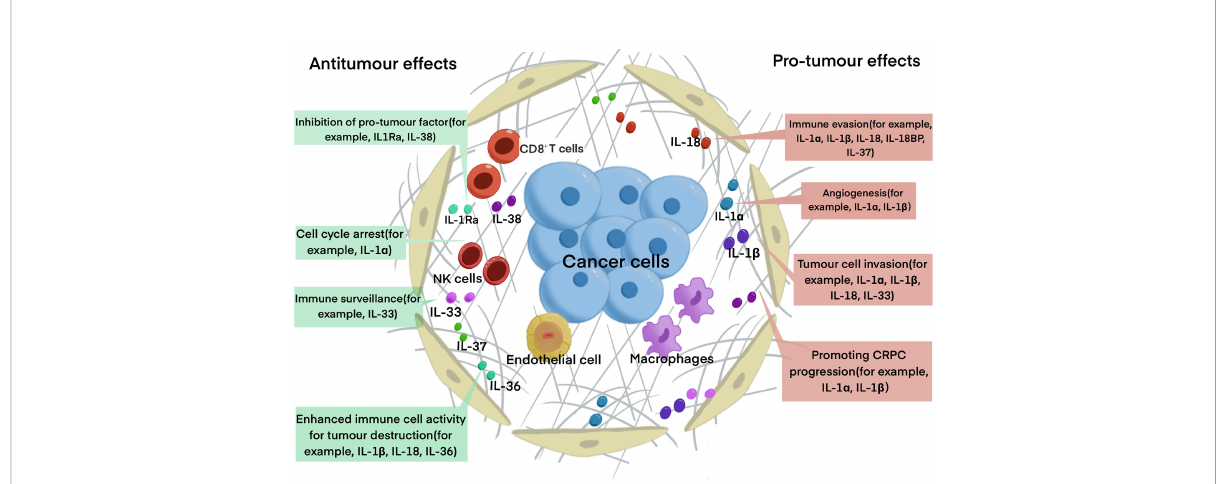
FIGURE 2 The roles of IL-1 family in PCa progression. The diagram summarized the major function of IL-1 family has in PCa progression. Some of the cytokines, for example, IL-1Ra, IL-33 and IL-37 have anti-tumor function, IL-1 a and IL-1 b have pro-tumor function, while IL-18 and IL-33 have dual